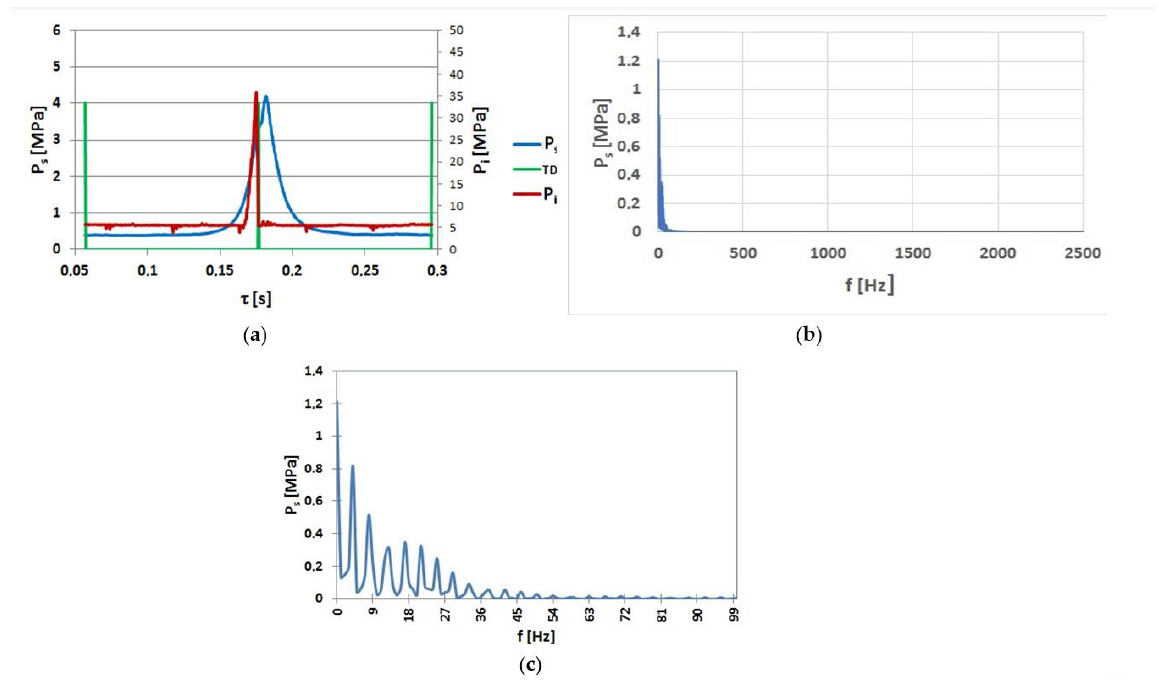
Figure 2. The time τ waveforms of the pressure signal in the injection subsystem P i and the in-cylinder P s of the marine internal combustion engine ( a ), example analysis in the frequency band 0–2.5 kHz ( b ) and a fragment of the spectrum from Figure 2b in the frequency band 0–100 Hz ( c